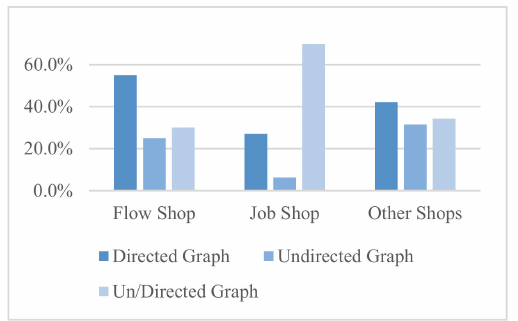
Figure 28. Overlap between Graph types and Shop